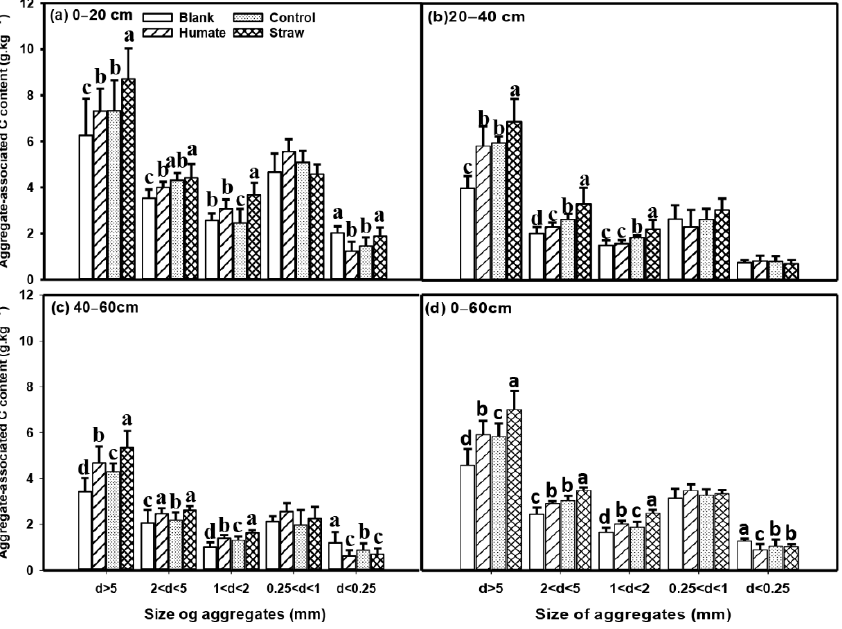
Figure 2. SOC concentrations in different soil layers 0–20 cm( a ), 20–40 cm ( b ), 40–60 cm ( c ) and 0–60 cm ( d ) estimated using the fixed depth method in 2018 at the end of the 3-year experiment. Signif- icant differences are indicated by lowercase letters (a, b, c) according to LSD test at p < 0.05 level. Error bars represent the standard deviation (SE).